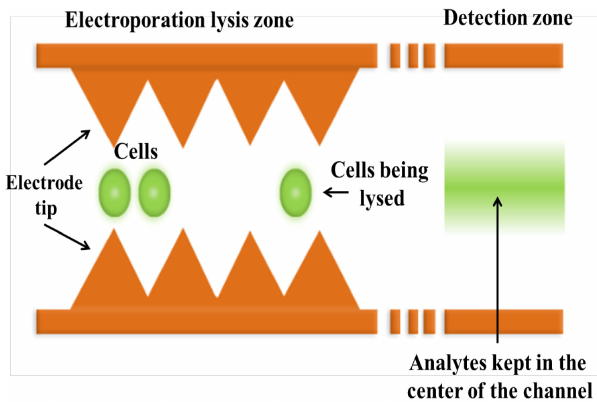
Figure 10. Schematic representation of microfluidic cell lysis device where saw-teeth microelectrodes acting as a dielectrophoresis effect on the device for focusing intracellular material after electroporation. Figure has been redrawn from reference [88].